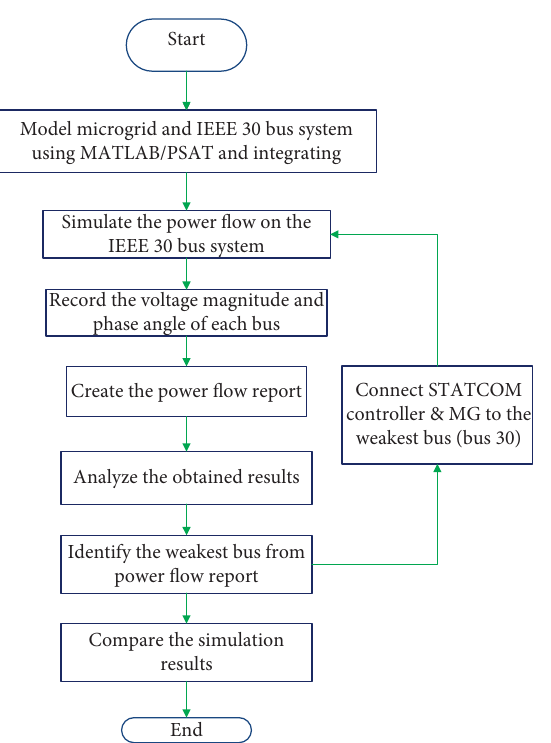
Figure 7: Flow diagram of simulation using